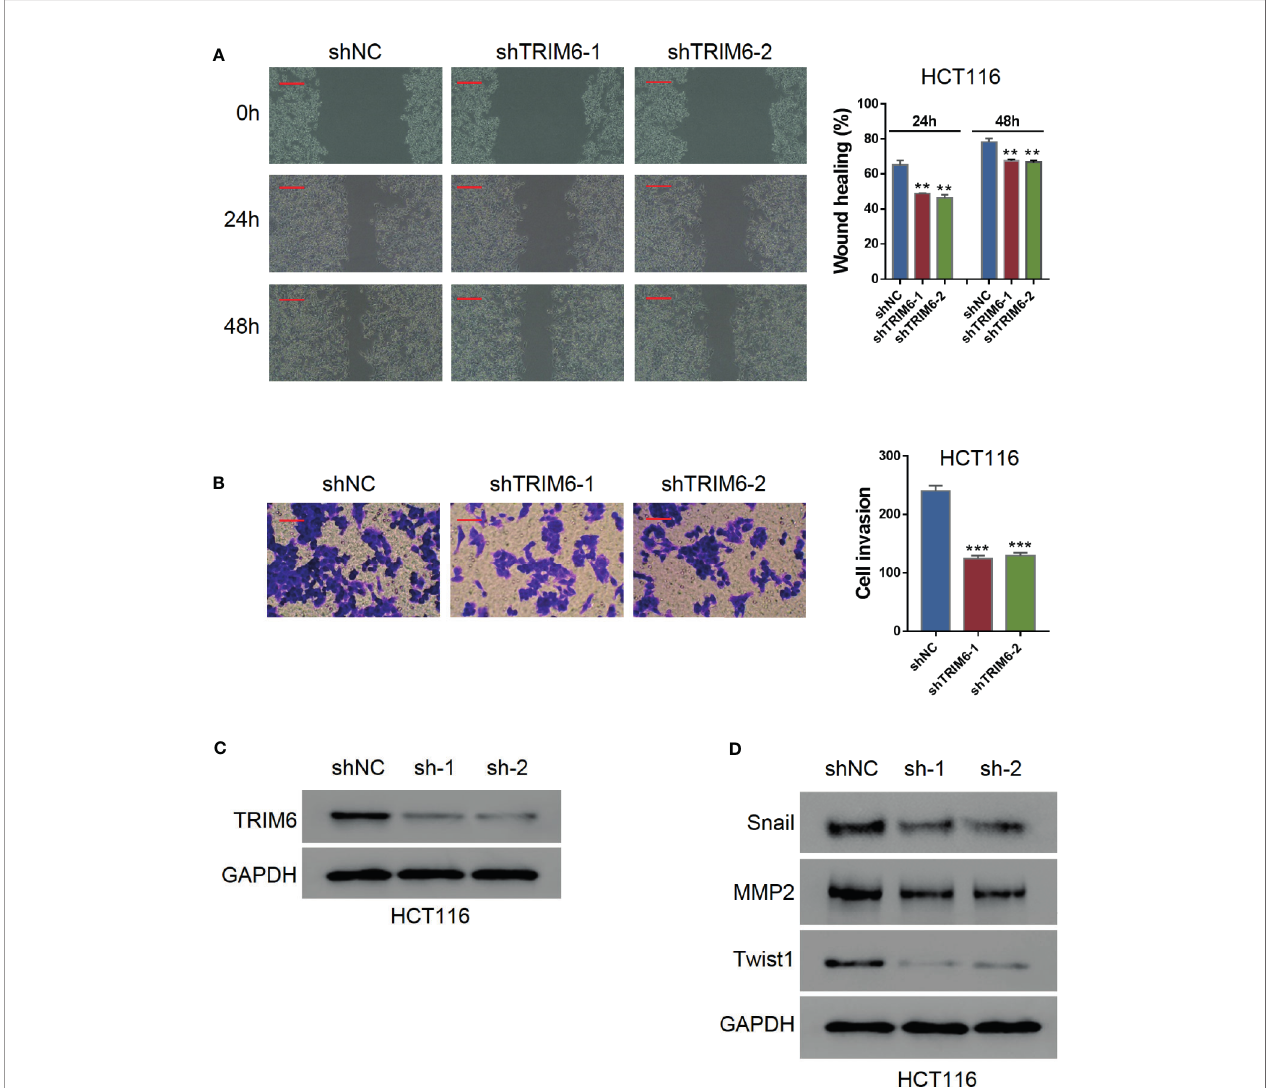
FIGURE 1 | TRIM6 knockdown inhibits CRC cell migration and invasion in HCT116 cells. (A) Western blots images for validating TRIM6 knockdown by shRNAs. (B) Representative images and quantitative analysis of wound-healing assay at 0, 24, and 48 h post-scratching. shNC, negative control; shTRIM6-1, shRNA-1; shTRIM6-2, shRNA-2. Scale bar: 100 µm. (C) Representative images and quantitative analysis of the cell invasion assay. Scale bar: 100 µm. (D) Detecting the expression of Snail, MMP2, and Twist. The results are from at least three separate experiments. **P < 0.01, ***P < 0.001 vs.